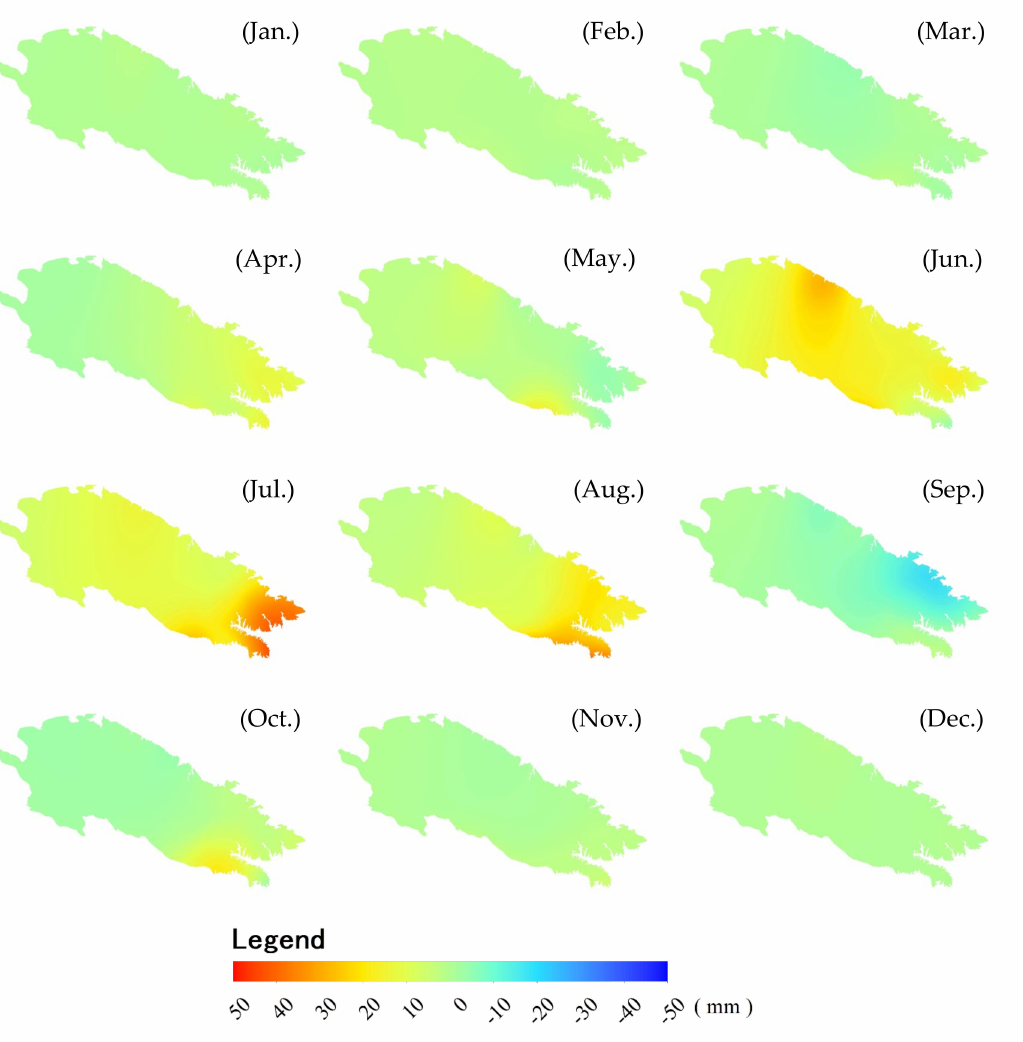
Figure 7. Difference in monthly average precipitation for 20 years by linear regression from 2000 to 2019 per